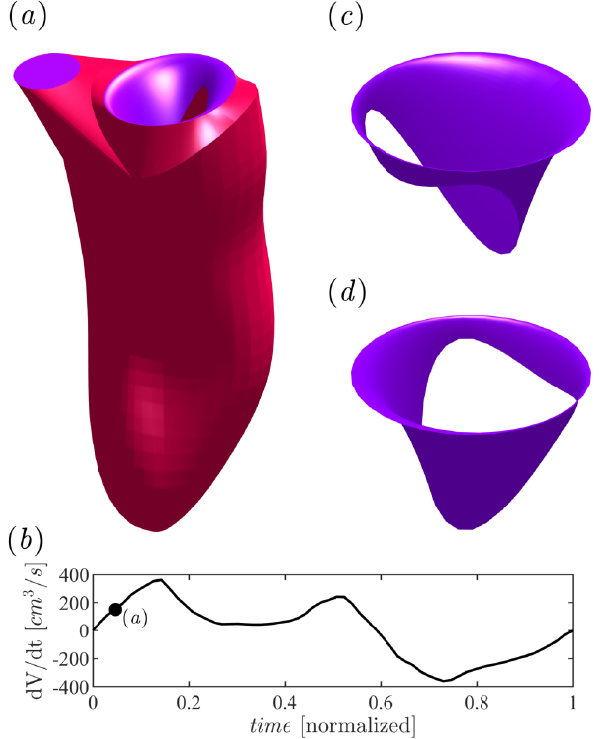
Figure 1. LV geometry ( a ) and its dV/dt curve ( b ). Ideal MV in semi-open configuration for (cid:101) = 0.6 ( c ) and (cid:101) = − 0.6 ( d ),